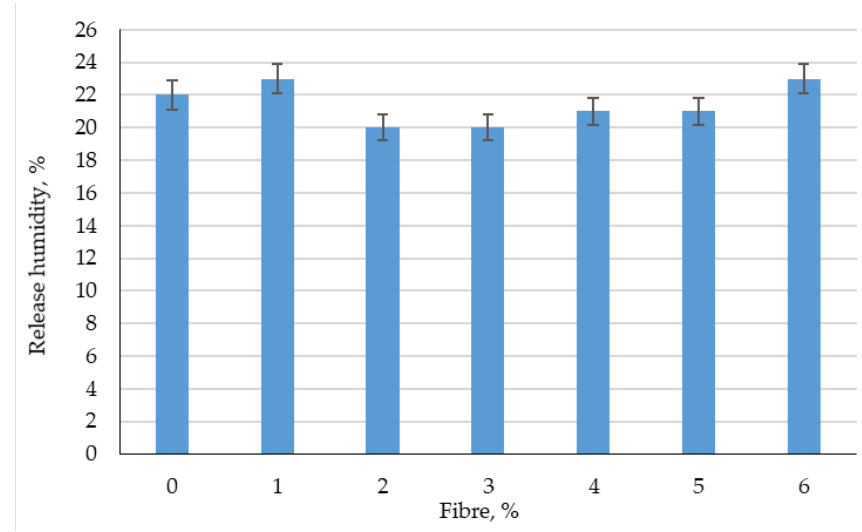
Figure 7. Results of experimental studies of the release moisture content of fiber foam concrete samples at various dosages of polypropylene fiber.